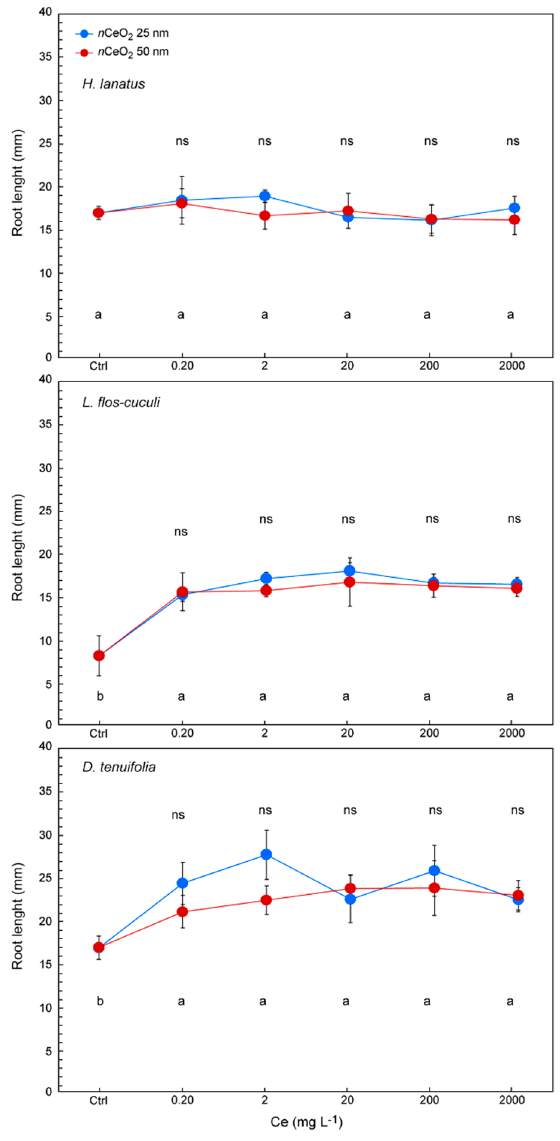
Figure 4. Root length in seedlings of H. lanatus , L. flos-cuculi and D. tenuifolia , grown in Petri dishes and treated with solutions of n CeO 2 25 nm and n CeO 2 50 nm at 0, 2, 20, 200 and 2000 mg L − 1 , respectively. The values are mean ± SD (standard deviation) of 3 replicates. Statistical significance of the treatments for each Ce concentration is reported: (i) figure upper part → comparison between n CeO 2 25 nm and 50 nm; (ii) figure lower part → comparison between all treatments. Different letters indicate statistical differences. ns = not significant, * p ≤ 0.05, ** p ≤ 0.01.